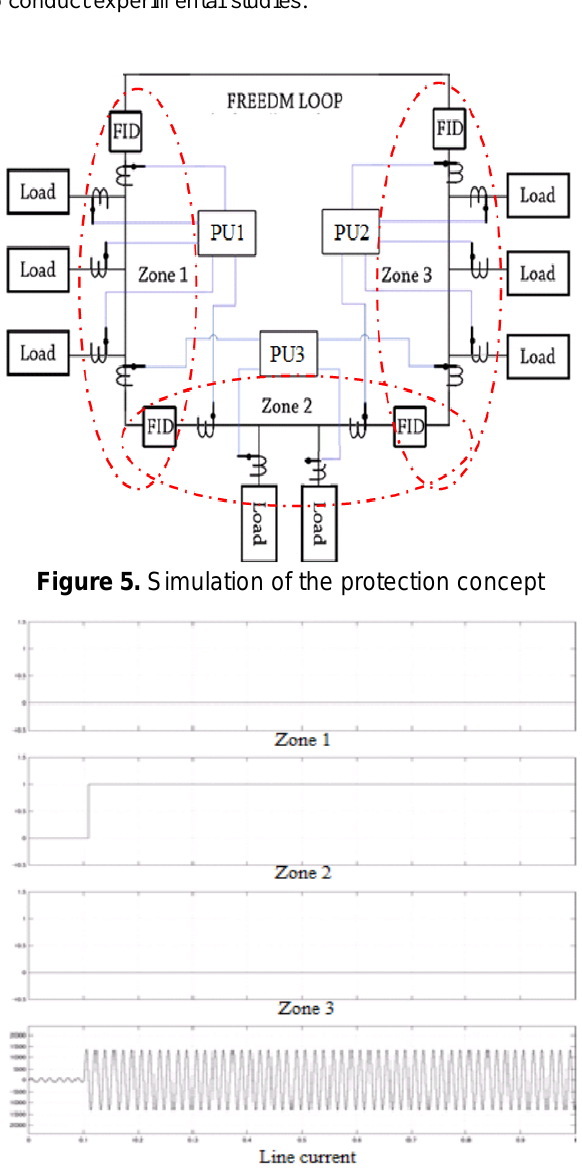
Figure 6. The protection result: 4 scopes represent the output of the protection unit in zone 1, 2, 3, and the current in the FREEDM loop, respectively. When a fault occurs in zone 2, the protection unit 2 trips while the units in the other zones remain silent.